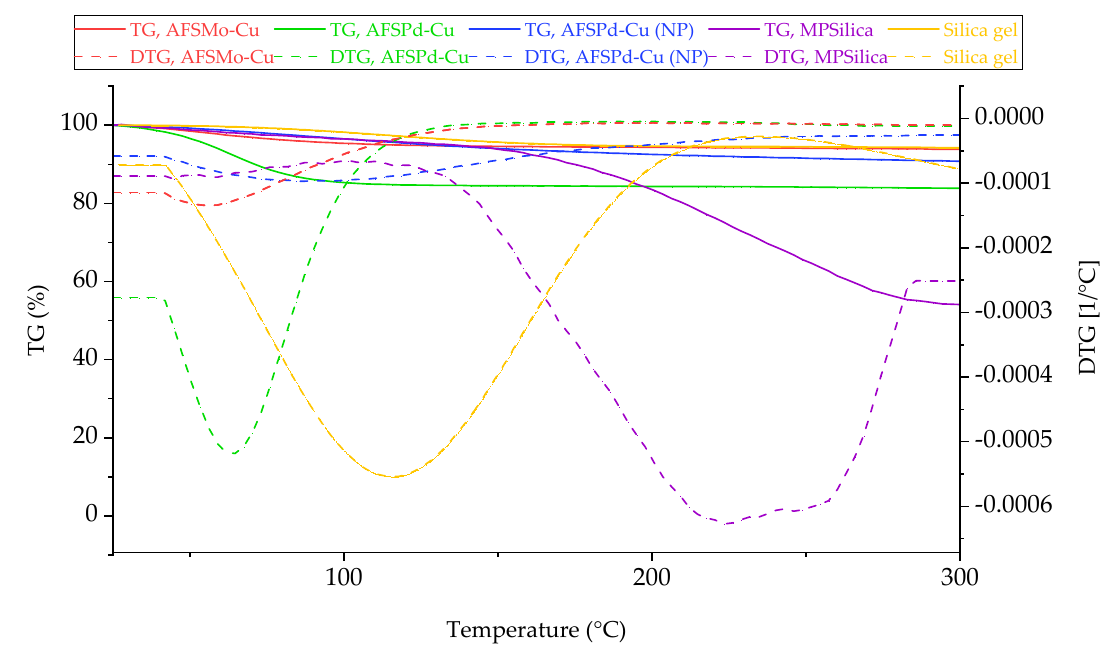
Figure 11. Thermal behaviour of analysed sorbents up to 300 °C in oxidising atmosphere.